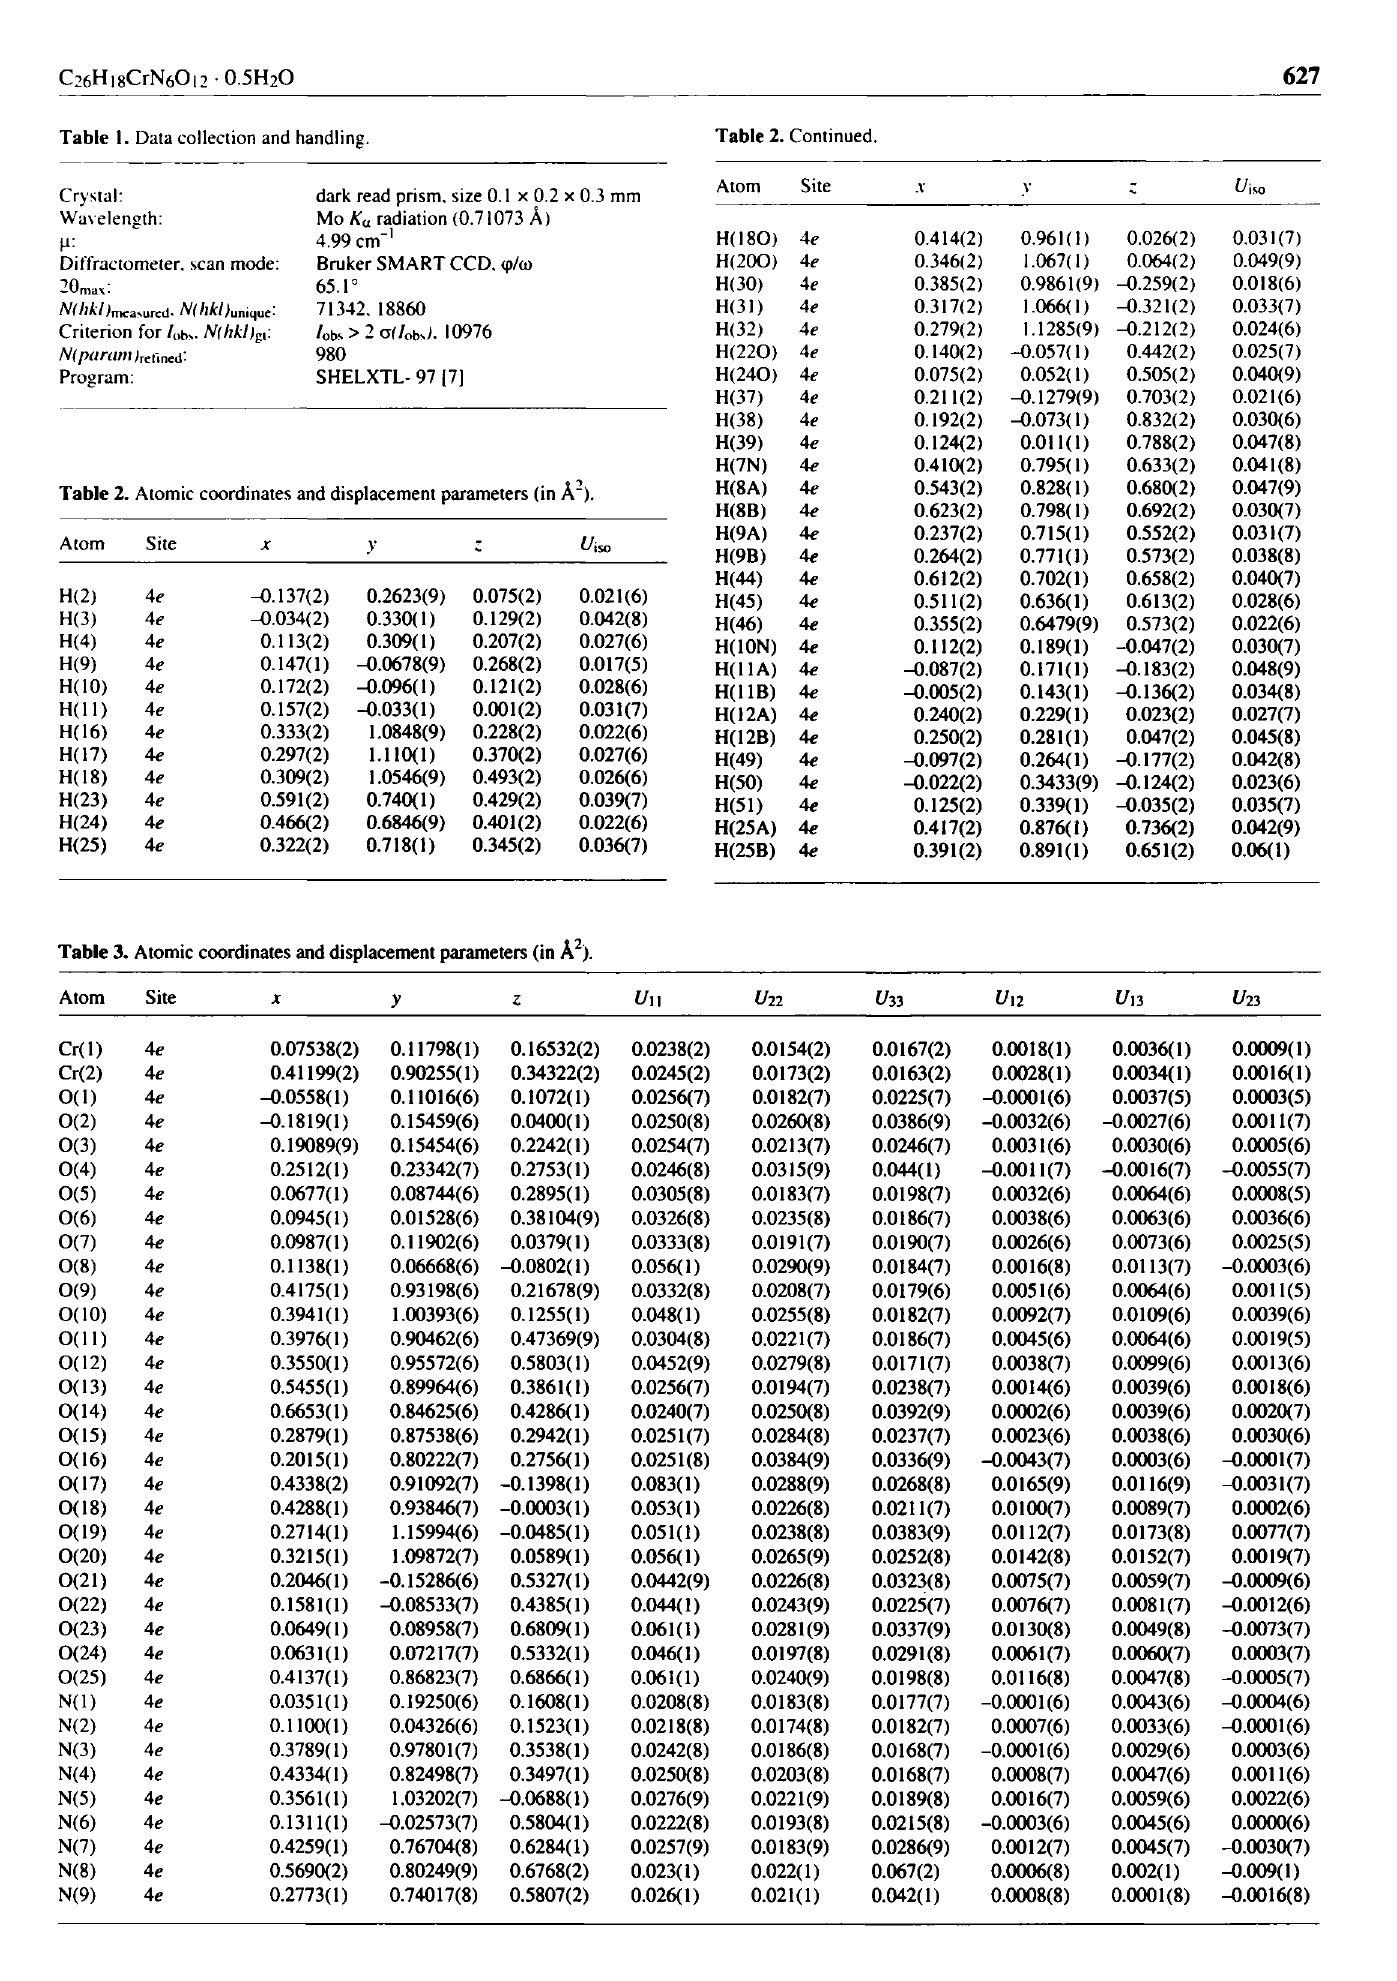
Table 2. Atomic coordinates and displacement parameters (in A 2 ).